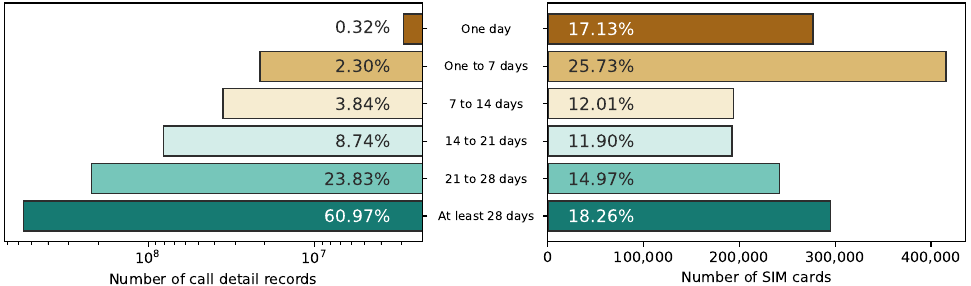
Figure 3. SIM card distribution of the “April 2017” data set, by the number of active days. The left figure shows the number of CDRs and the right figure shows the number of SIM cards in each category. Around 45.13% of the SIM cards have activity on at least 14 different